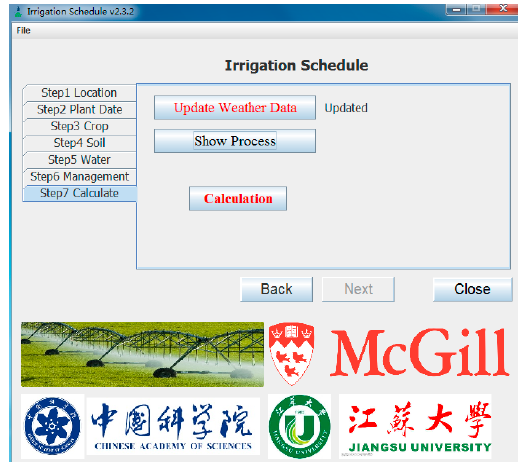
Figure 3. Main interface of IrrSch software.